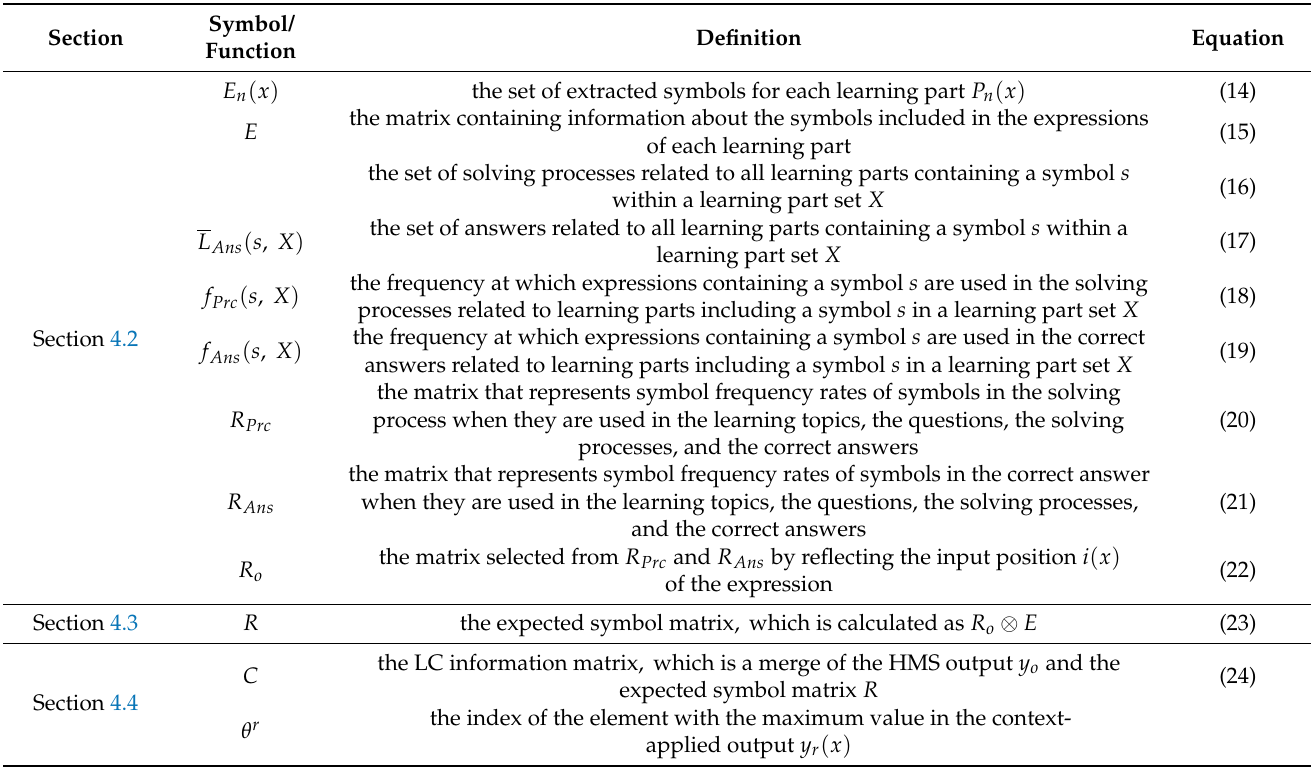
Table A2. Definitions of Symbols and Functions in Section 4.